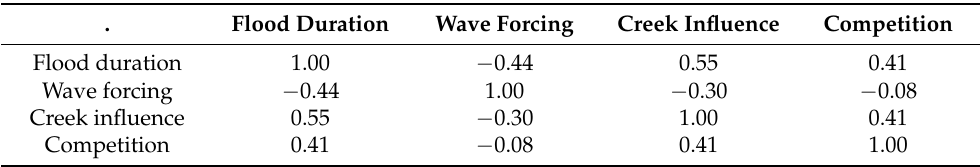
Table 4. The spatial driver correlation coefficients, all spatial drivers were significantly correlated with p values <